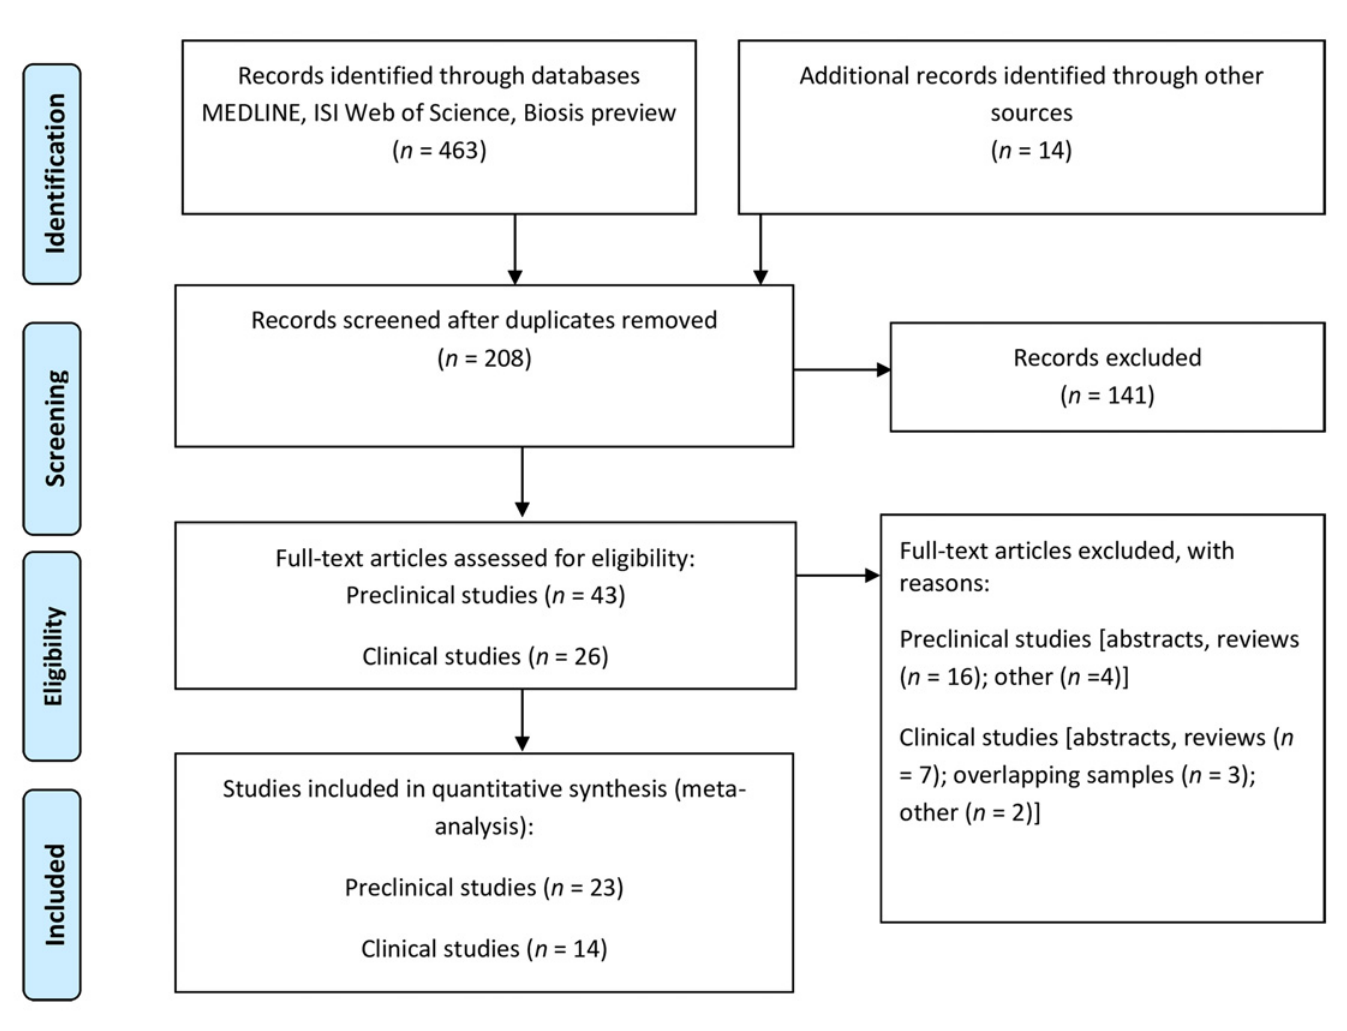
Fig 1. Prisma flow diagram of the search strategy and its